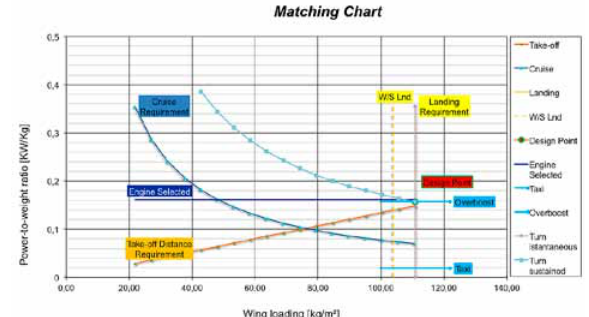
Fig. 9. Matching Chart for the reference